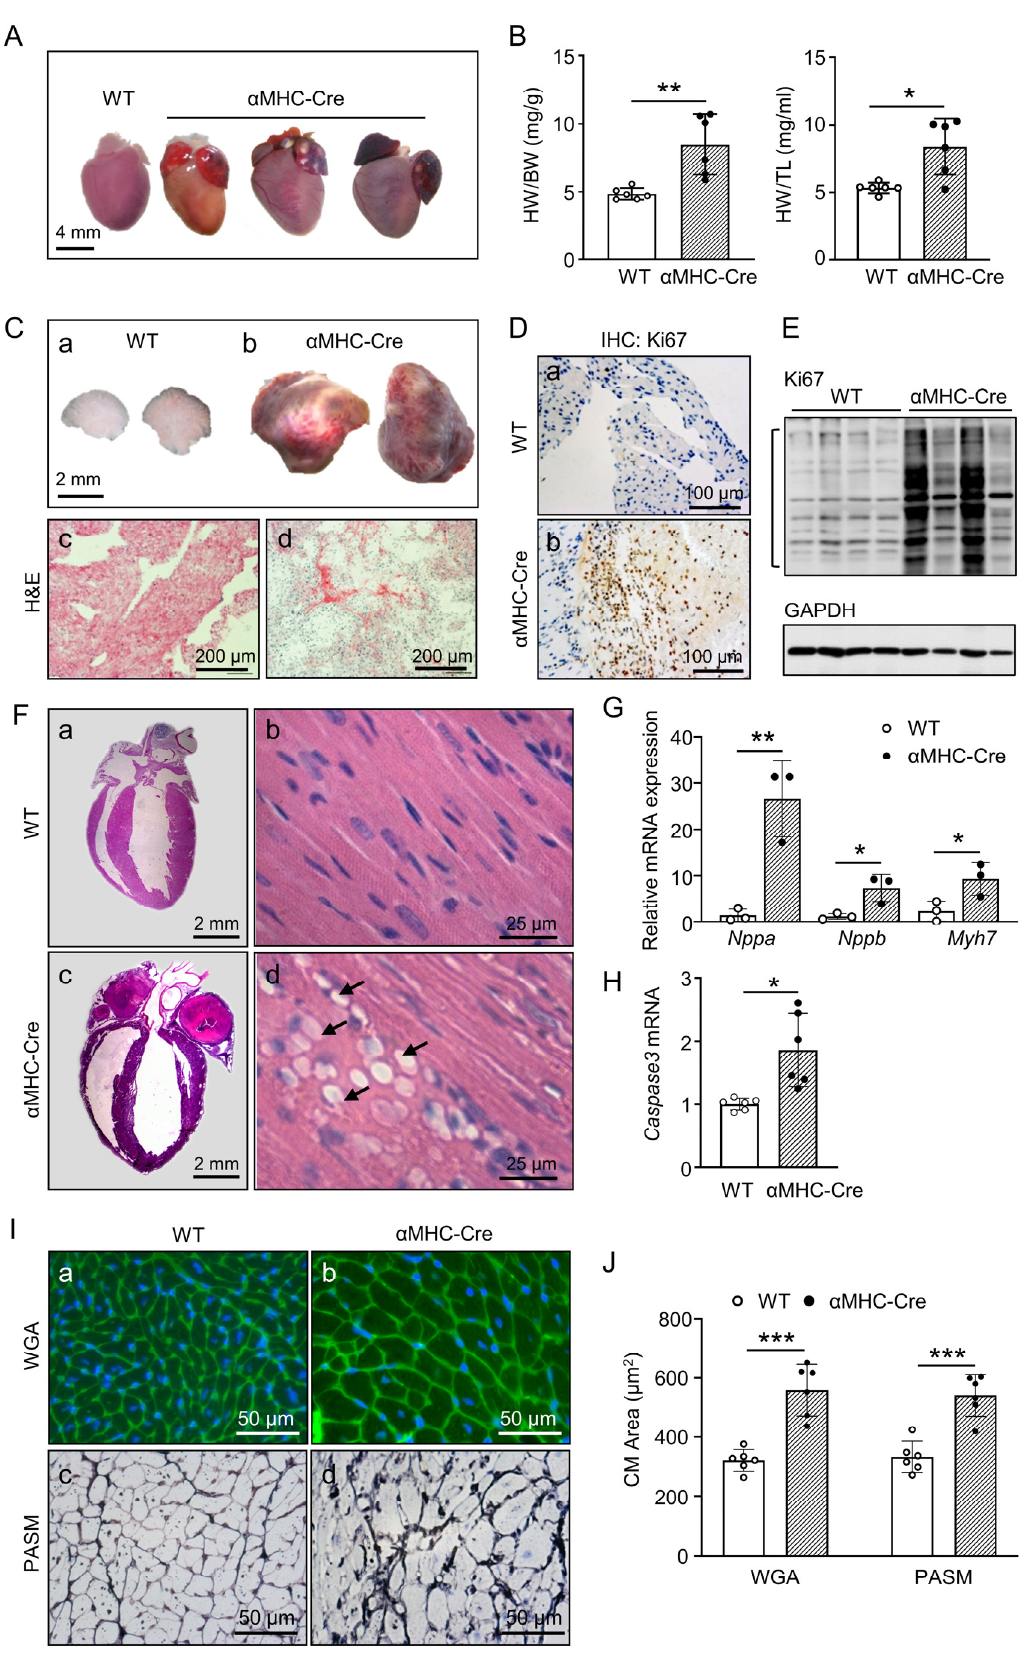
Figure 2. Tumor-like atrium and cardiomyocyte death lead to cardiac remodeling and heart failure in α MHC-Cre mice at six months of age. ( A ) Representative morphological images of the heart from WT and α MHC-Cre mice at six months of age. Scale bar, 4 mm. ( B ) Summary of the HW/BW and